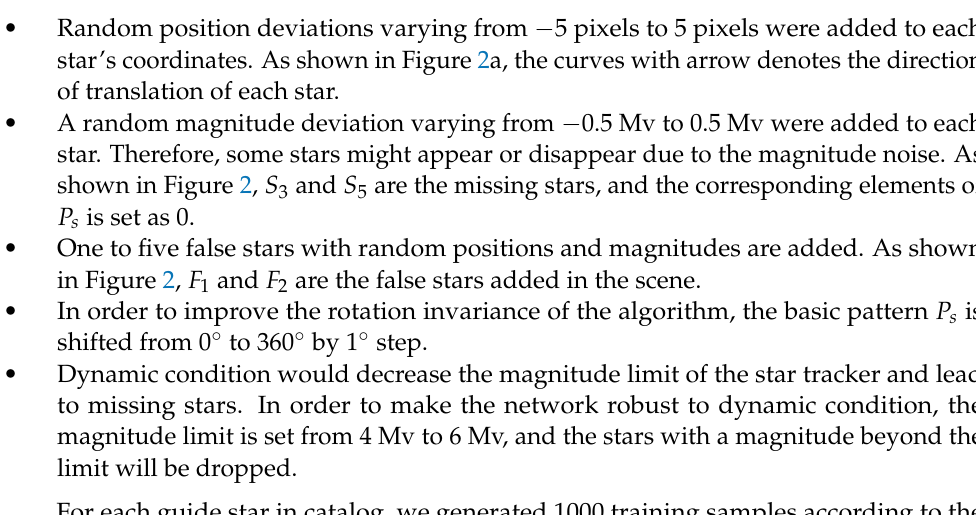
Figure 2. ( a ) original star image. ( b ) constructed star